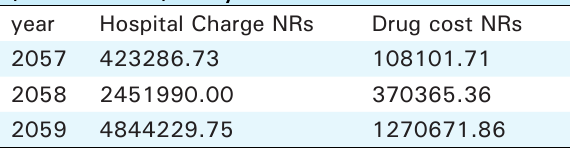
Table 4. Average Expenditure under different heads (Undiscounted) in 3 yrs variation.